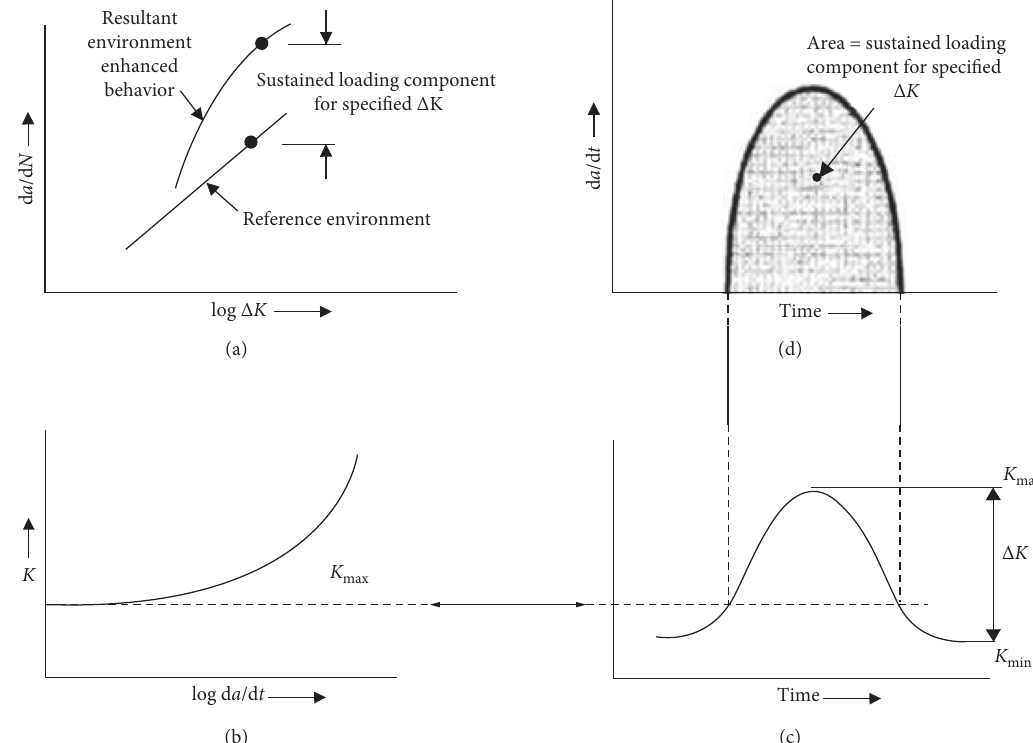
Figure 10: Schematic diagram illustrating the linear superposition hypothesis: (a) integrating effect on the environment of fatigue crack growth rate; (b) crack growth rate under sustained load in aggressive environment; (c) environmental contribution; (d) sustained loading component due to constant